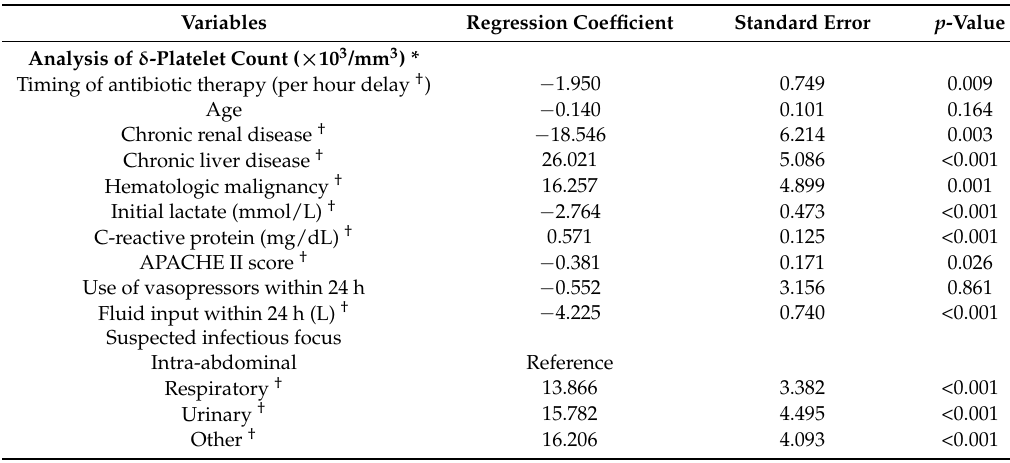
Table 3. Multivariable linear regression